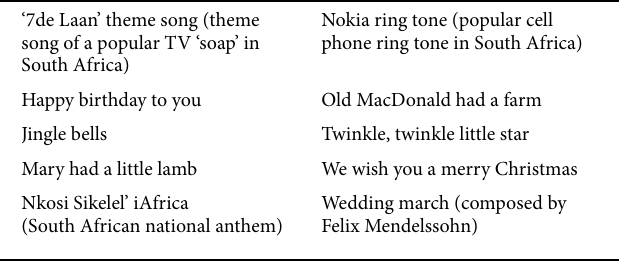
Table III. Songs included in the familiar melody identification task (sub-test 10)